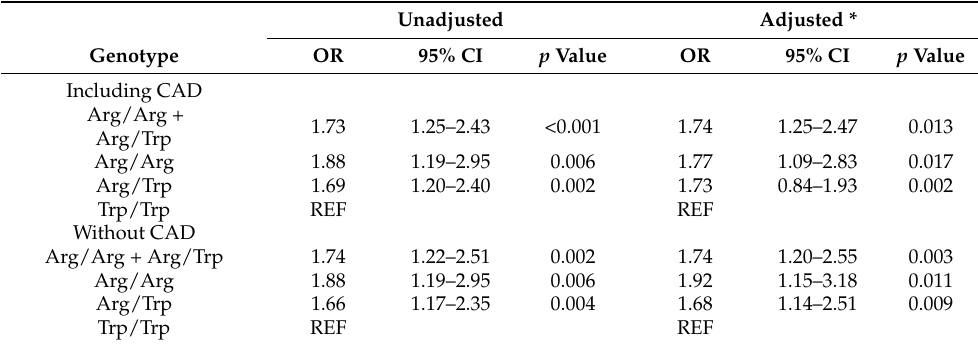
Table A1. Association of KIF6 719Arg with thoracic aortic dissection (typical and intramural hematoma cases), with or without